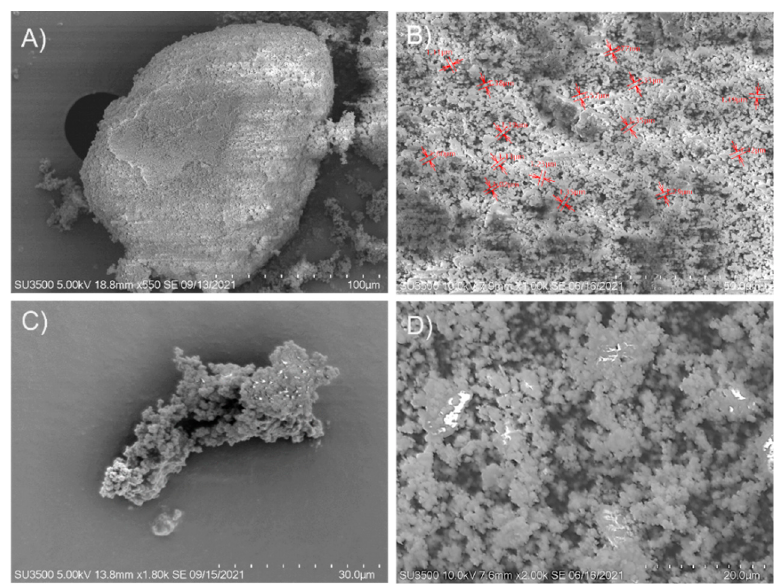
Figure 7. SEM Image of commercial zeolite ( A , B ) and recombinant β -glucosidase immobilized on zeolite ( C , D ).